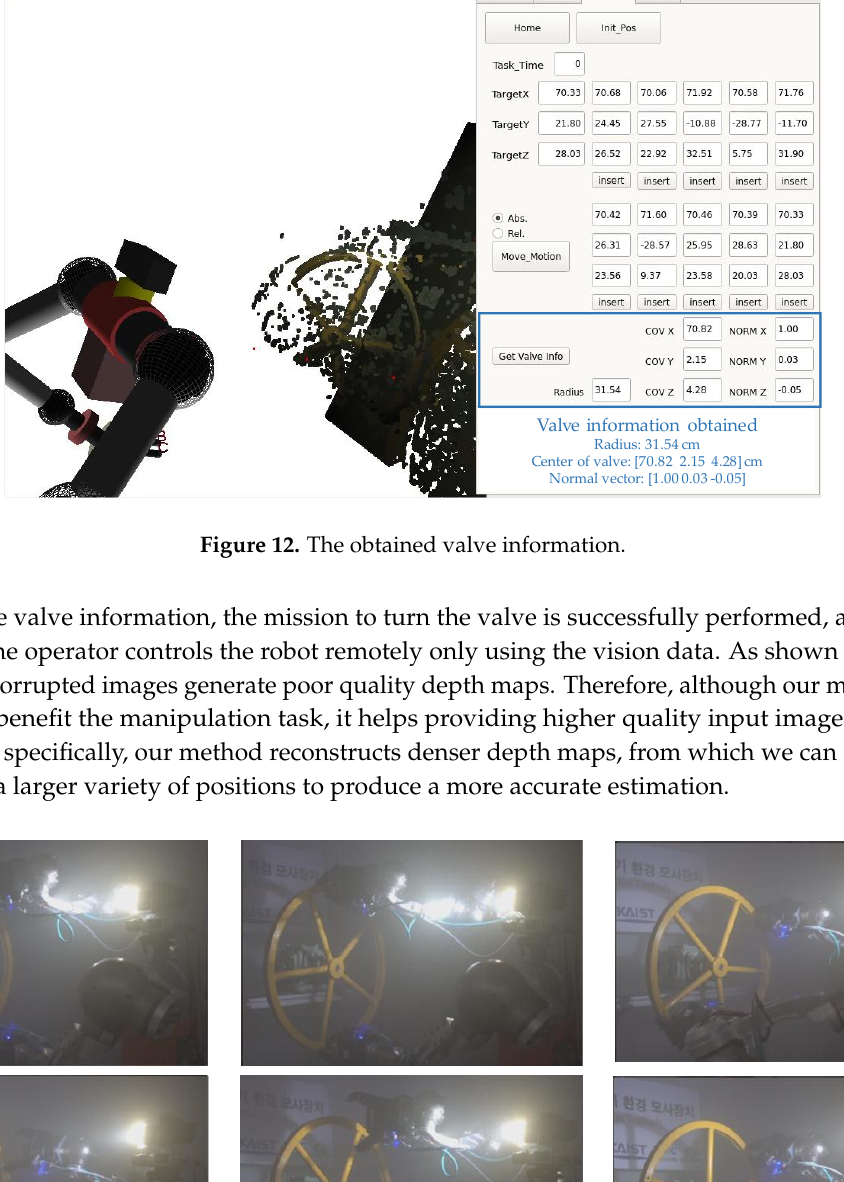
Figure 13. The snapshot of the robot turning the valve in dense fog condition.